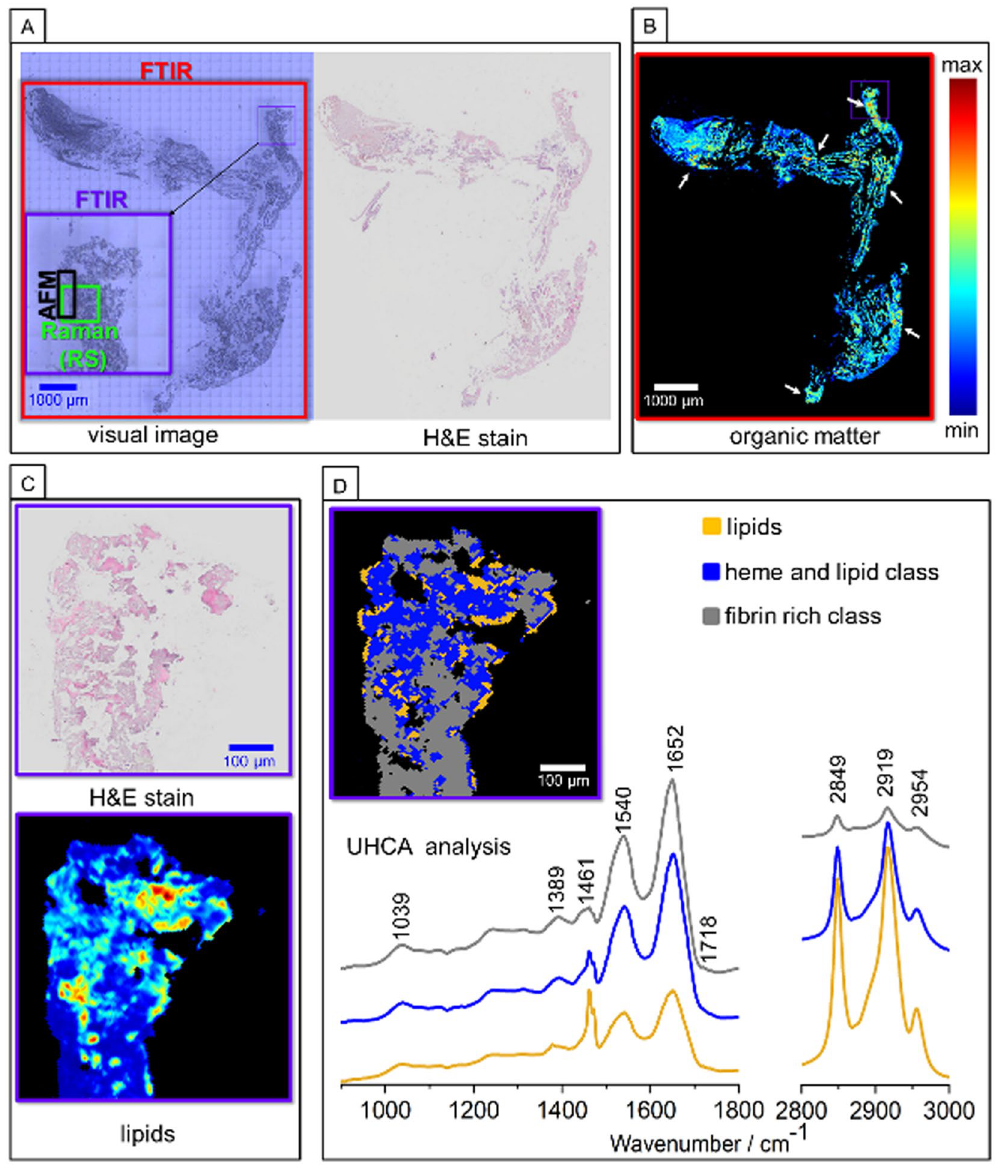
Figure 2. Representative FTIR imaging of human brain clot of a large vessel origin. ( A ) White–light optical image (20 × ) with marked ROIs for FTIR (red, purple), RS (green) and AFM (black) imaging with H&E stained image; ( B ) FTIR spectral image of distribution of organic matter (integration in the 2800–3100 cm − 1 region) with lipid–rich areas marked with white arrows; ( C ) H&E staining with the chosen ROI presented in ( B ), ( D ) the UHCA false–color map with mean FTIR